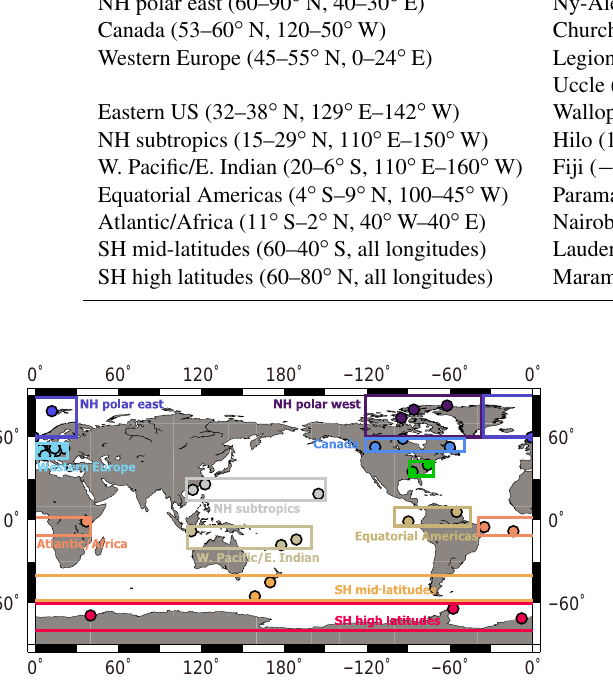
Figure 8. Regions and observation sites used in model evaluation. The 11 regions are defined following Tilmes et al. (2012). See also Table